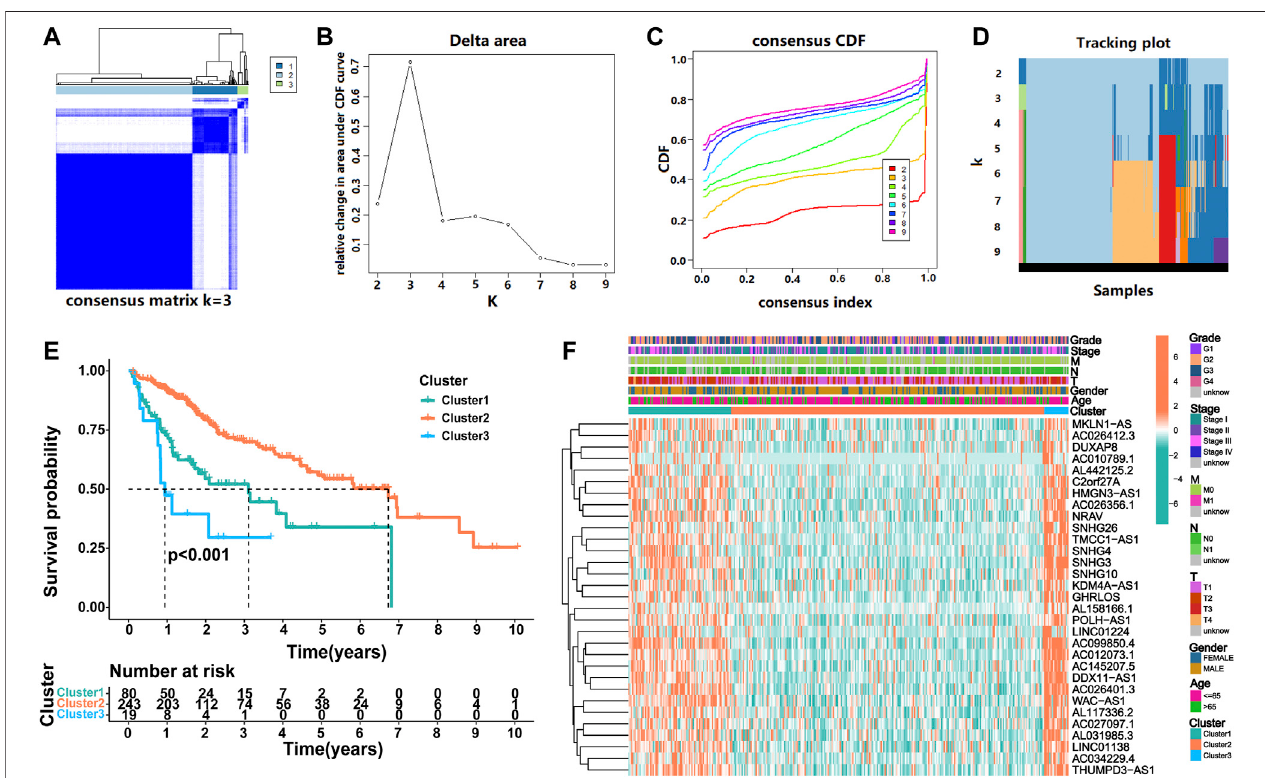
FIGURE2| ConsensusclusteringofprognosticlncRNAsrelatedtom6Aregulators. (A) Consensusclusteringmatrixfor k (cid:1) 3. (B) Consensusclusteringcumulative distribution function (CDF), (C) the relative change of area under the CDF curve and (D) tracking plot from k (cid:1) 2 to 9. (E) Kaplan – Meier curve of OS for three clusters in HCC. (F) The heatmap for expression levels of 31 m6A regulator-related prognostic lncRNAs in the TCGA cohort, based on the relationship between three clusters and clinicopathological